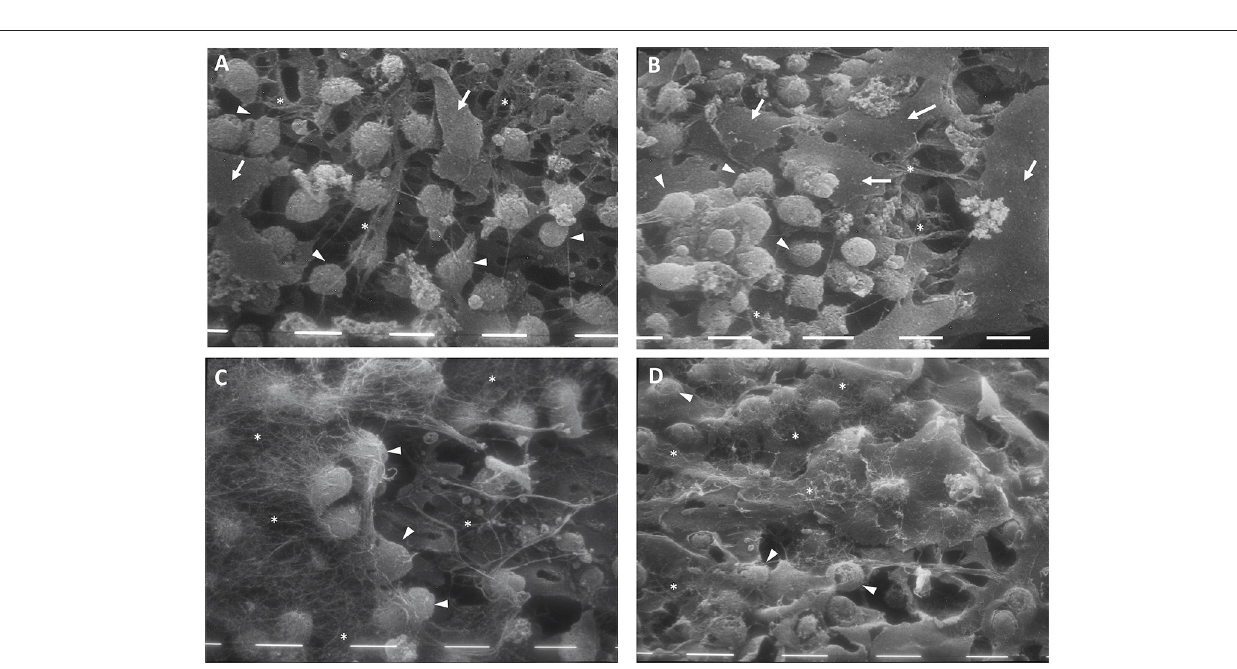
FIGURE 3 | Scanning electron microscopy (SEM) of chitosan scaffold (A,C) and chitosan scaffold prepared with hyaluronic acid (HA) (B,D) with chondrocytes after 4 weeks of culture with FBS (A,B) and PL (C,D) . White arrows: fibroblast-like cells; white tips: round cells; white stars: filaments of matrix. Scale bar = 10 µ m.